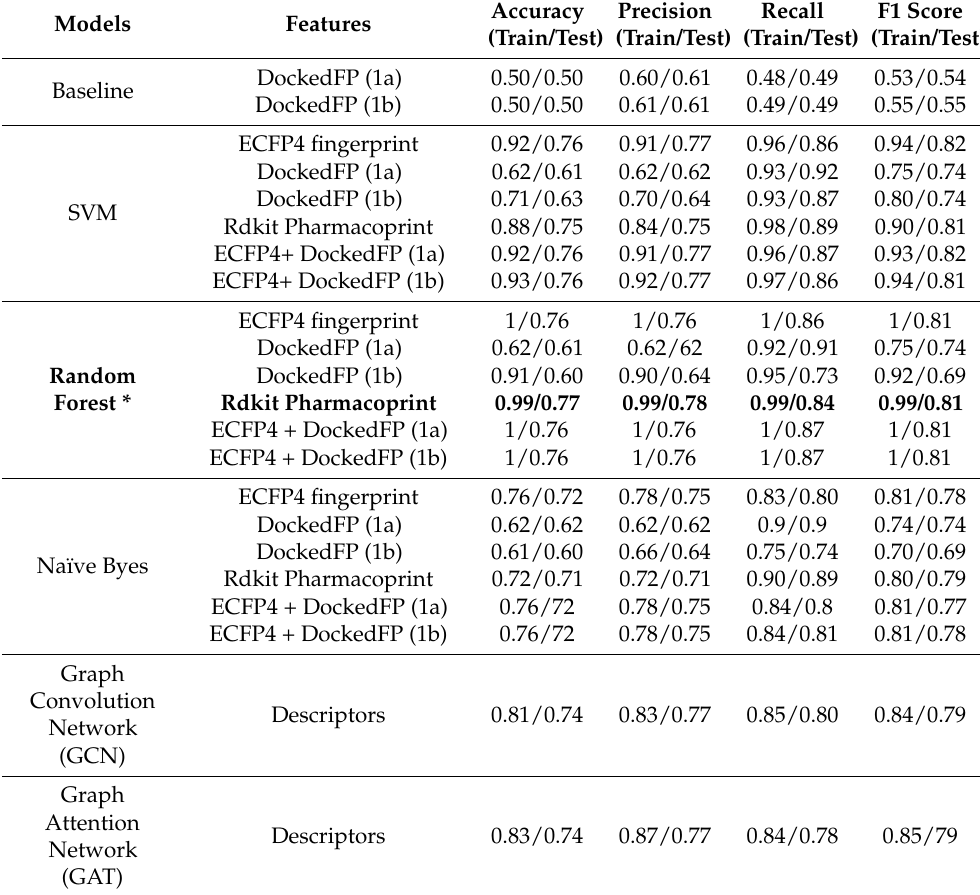
Table 1. Comparison of models for the different fingerprints.